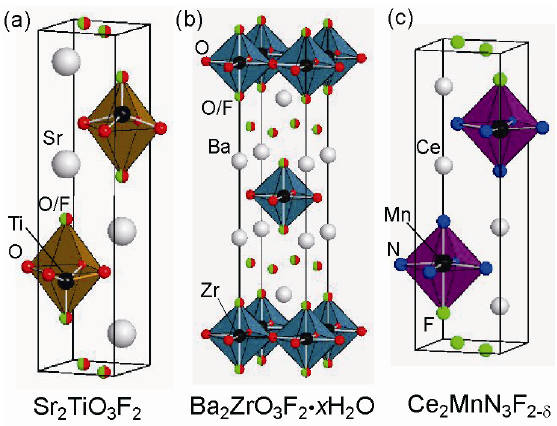
• x H ZrO F O, and ( c ) Ce 2 3 2 2